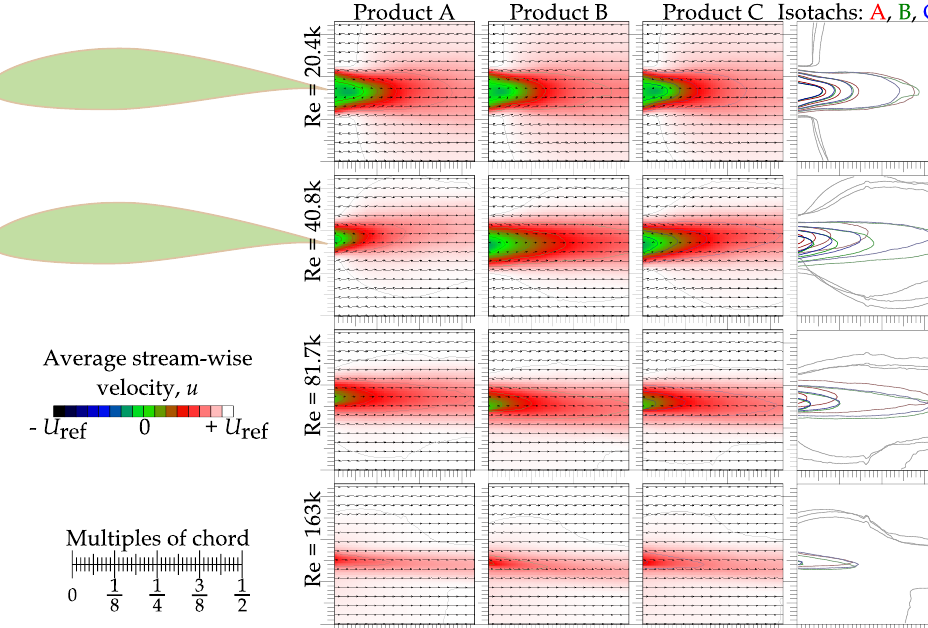
Figure 4. First three columns show the map of average stream-wise velocity u normalized by the reference velocity U ref past the slightly different samples A, B, and C. The fourth column displays isotachs together. The green tips on the left edge of the figure represent the positions of the airfoil trailing edge. The Reynolds number is based on the chord length and the reference velocity. The reference velocity is measured in the empty wind tunnel under otherwise similar conditions. Angle of attack α = 0 ◦ in all panels.